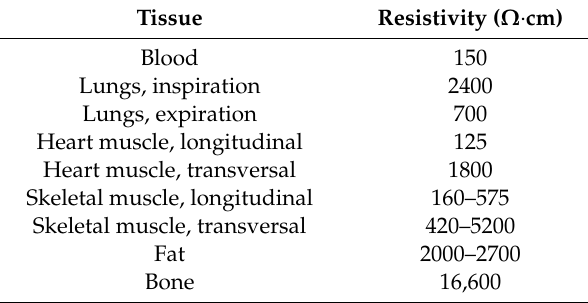
Table 1. Electrical resistivity of thoracic